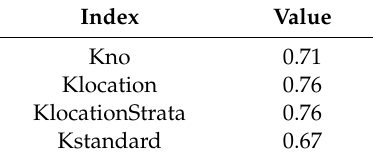
Table 5. Accuracy assessment of the simulated land use image of 2018.